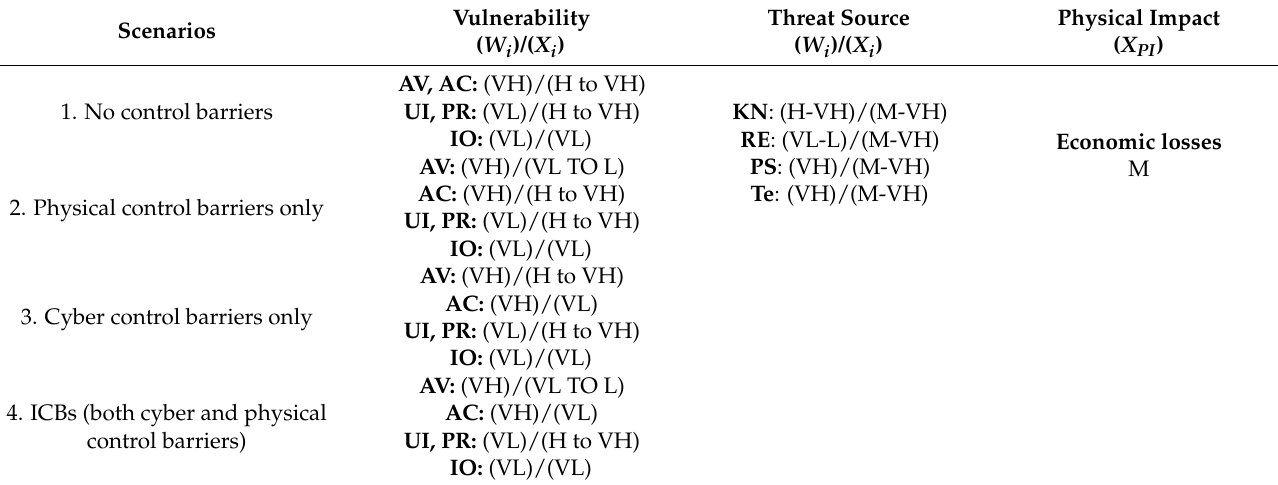
Table 4. Assigned scores to vulnerability, threat source and physical impact per